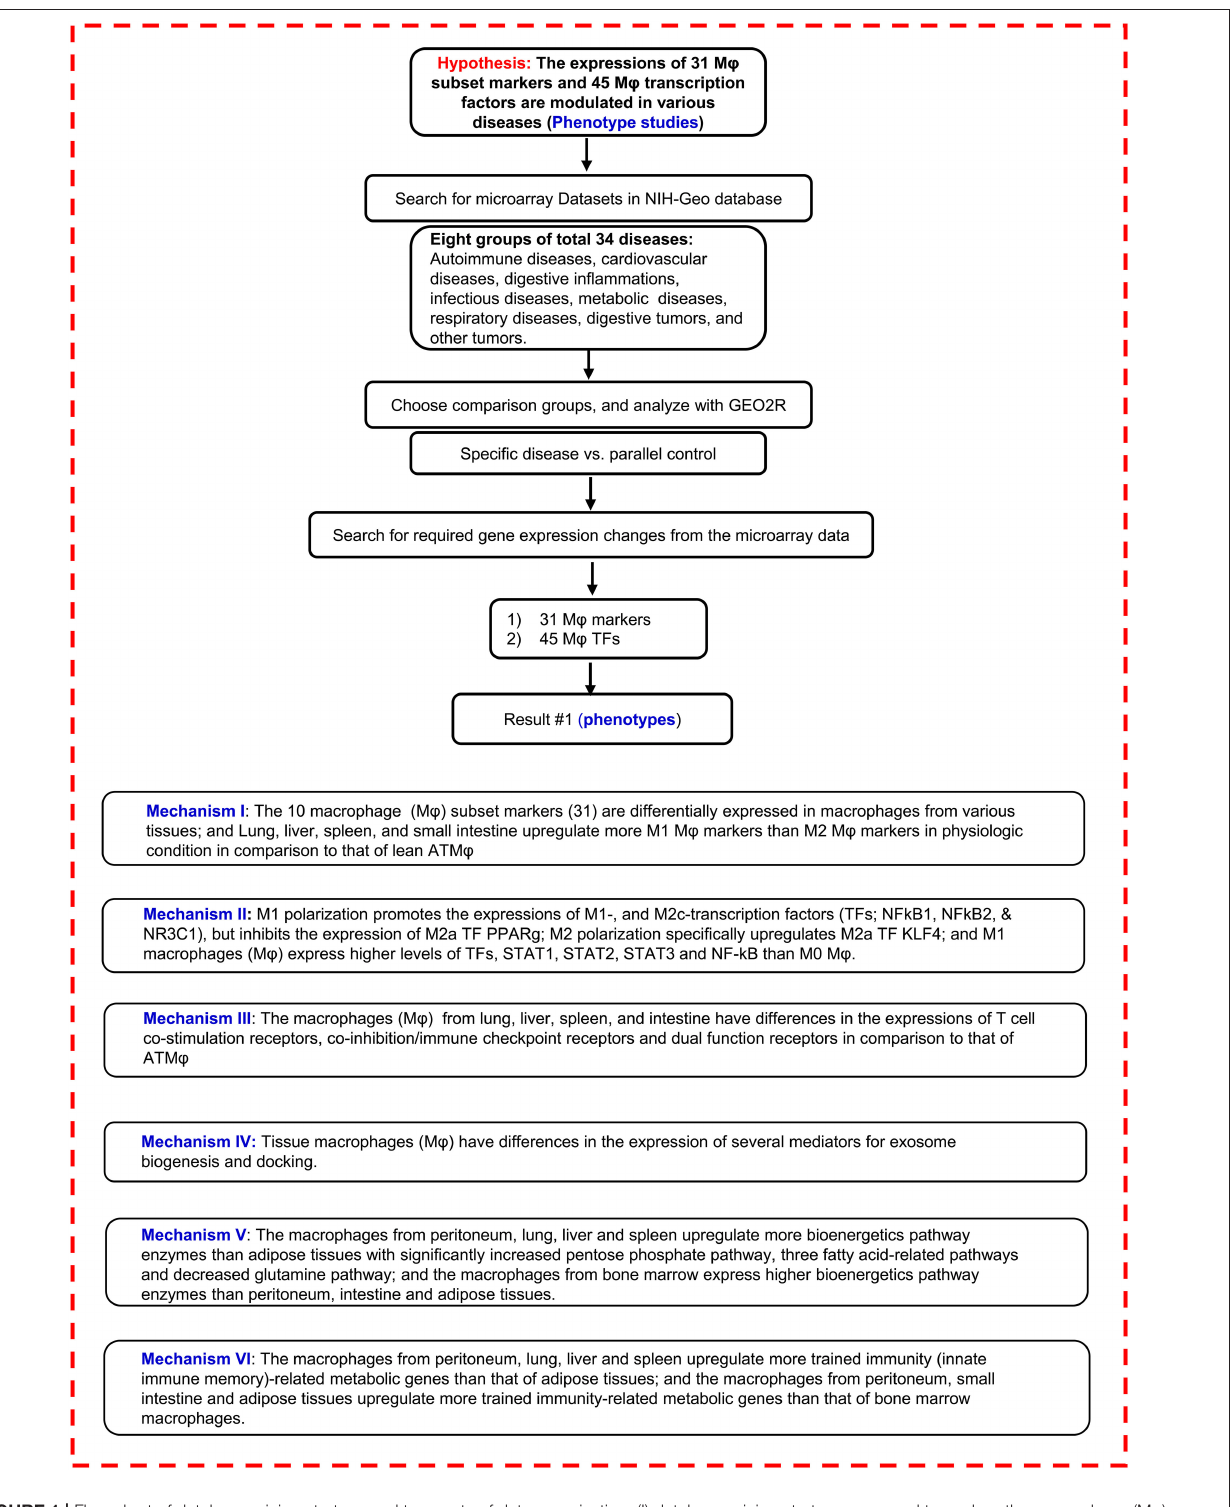
FIGURE 1 | Flow chart of database mining strategy and two parts of data organization. (I) database mining strategy was used to analyze the macrophage (M ϕ ) marker tissue expression profiles in physiological conditions. (II) M ϕ marker and M ϕ transcription factor expression changes were analyzed on experimental data from the microarray datasets in different